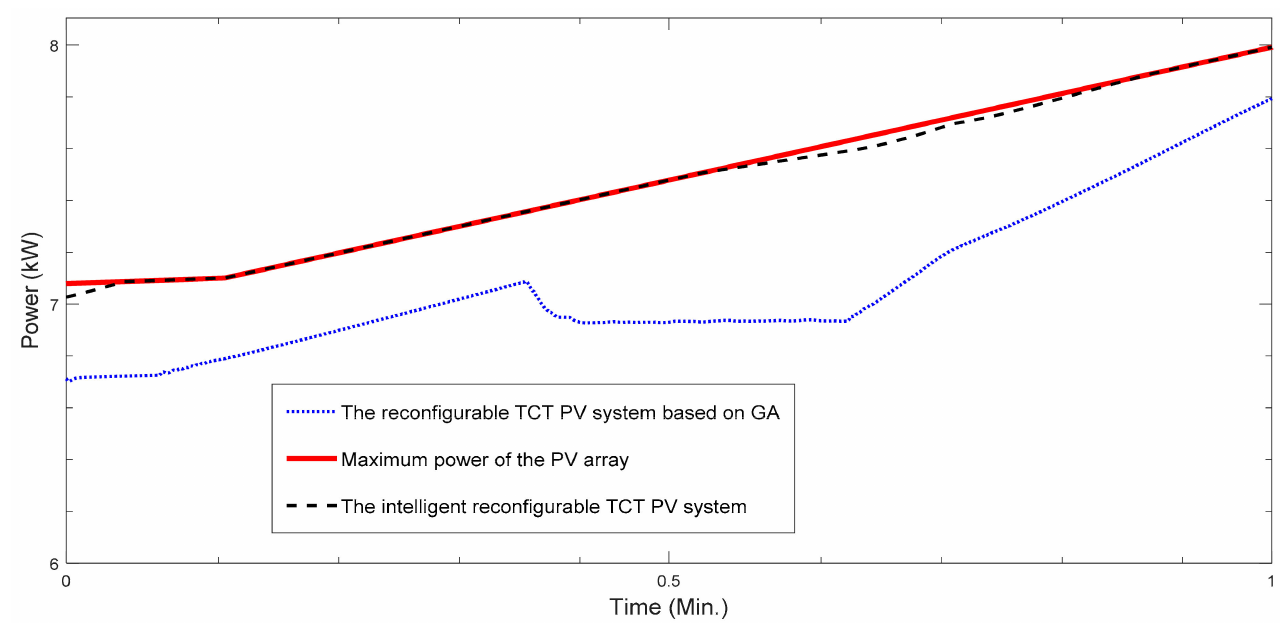
Figure 10. Curves of the generated power of rPV system based on the MFNN and